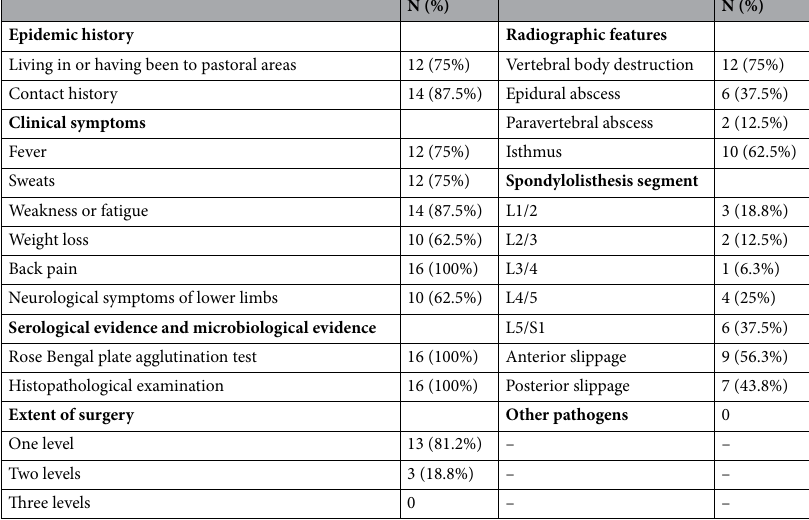
Table 1. Clinical data of patients.